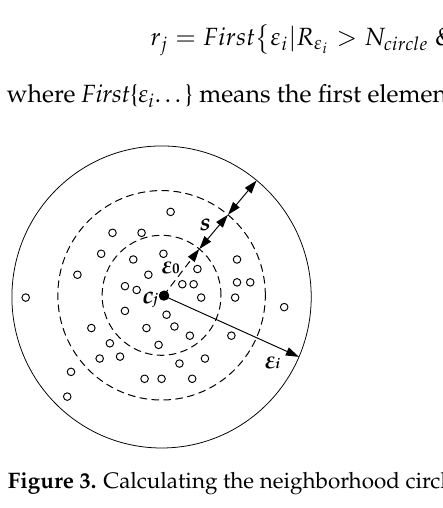
Step3: Construct the neighborhood circle for HG j using c j and the circle radius r j de-